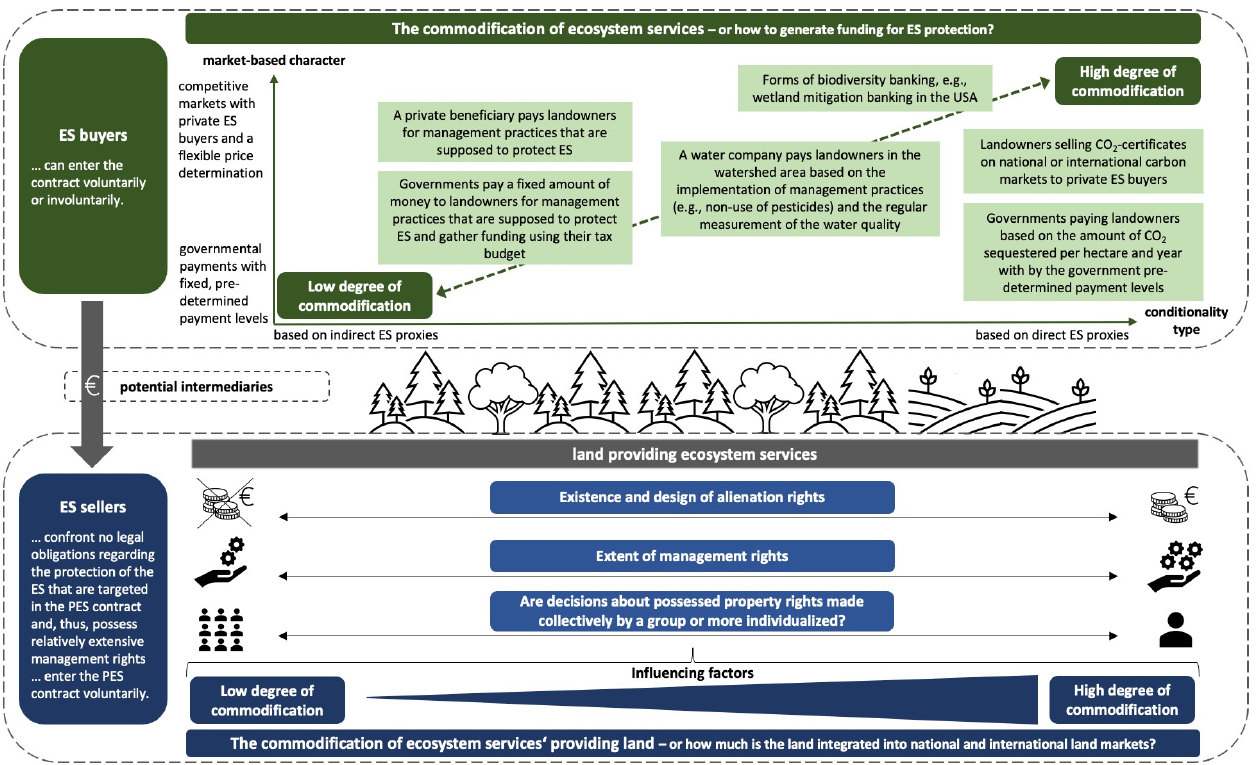
Fig. 2. Schematic representation of the two spheres of commodification. The placement of the examples in the ecosystem services (ES)-related sphere of commodification is only to be understood as a rough orientation; the exact placement is highly dependent on the individual example in